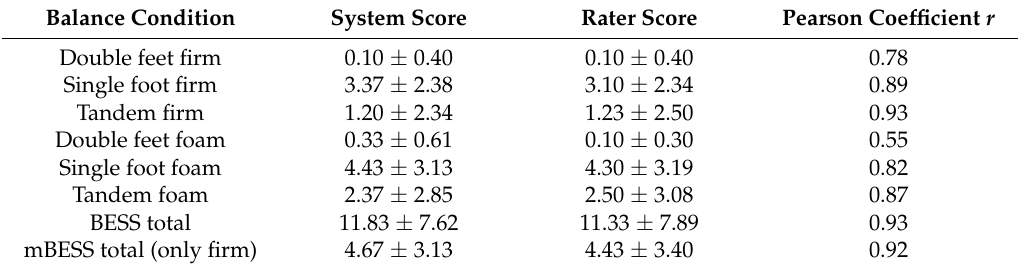
Table 3. The statistical results of the system and rater scores with Pearson coefficient value of each condition ( p < 0.05).